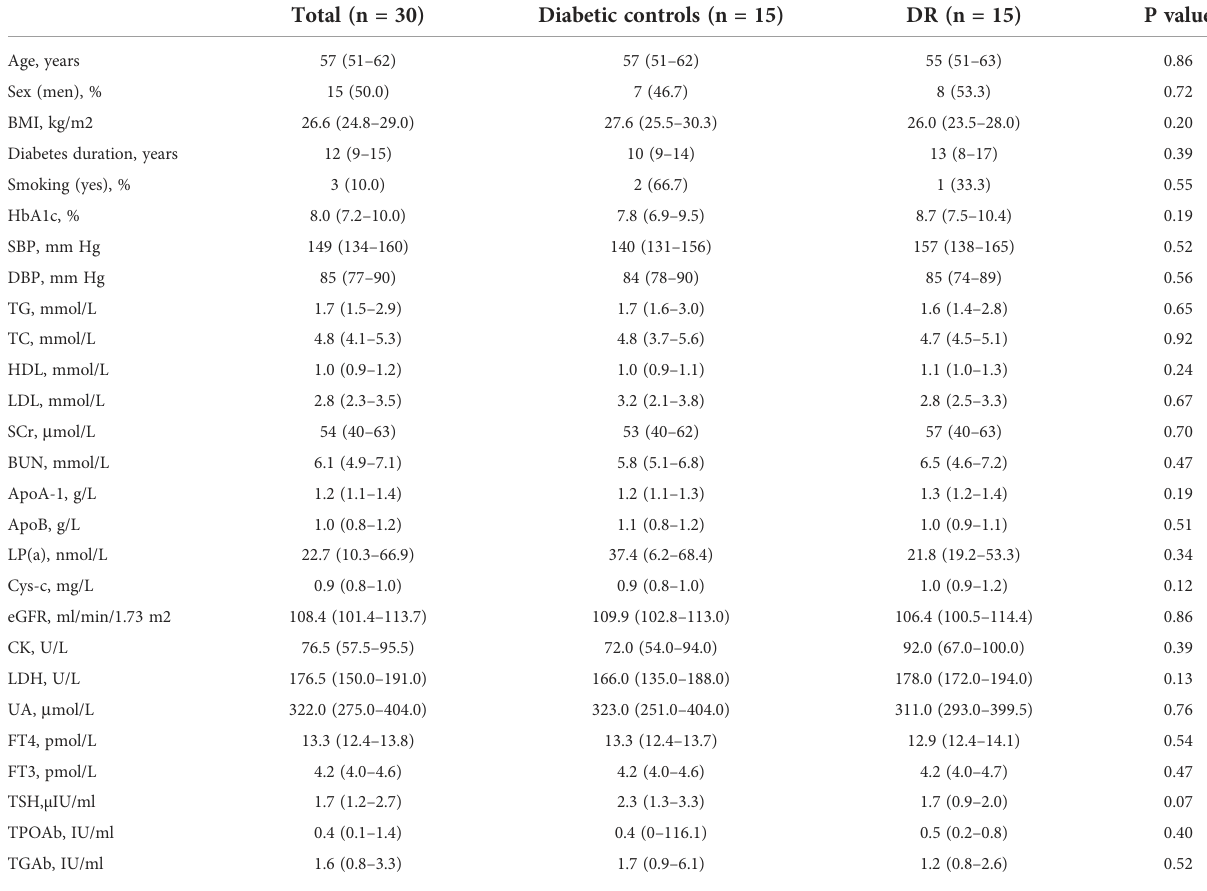
TABLE 1 Demographic and clinical characteristics of diabetic patients with and without